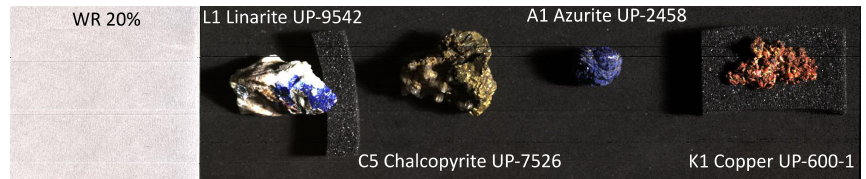
Figure 4. Showing HySpex scan MH_FK_LAB_Cudetect_008_09012018_WR20 as an example to highlight the lack of sample preparation.